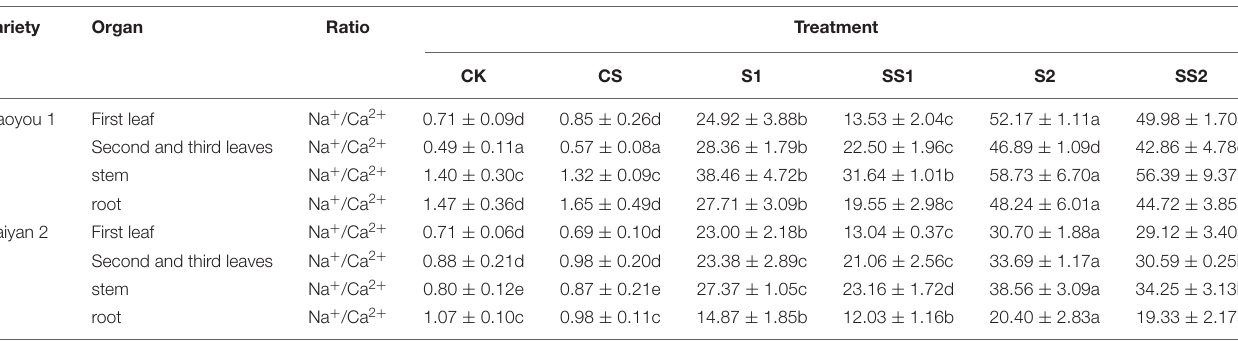
TABLE 2 | Effects of Spd application on Na + /Ca 2 + ratio under salt stress in the oat seedlings. Variety Organ